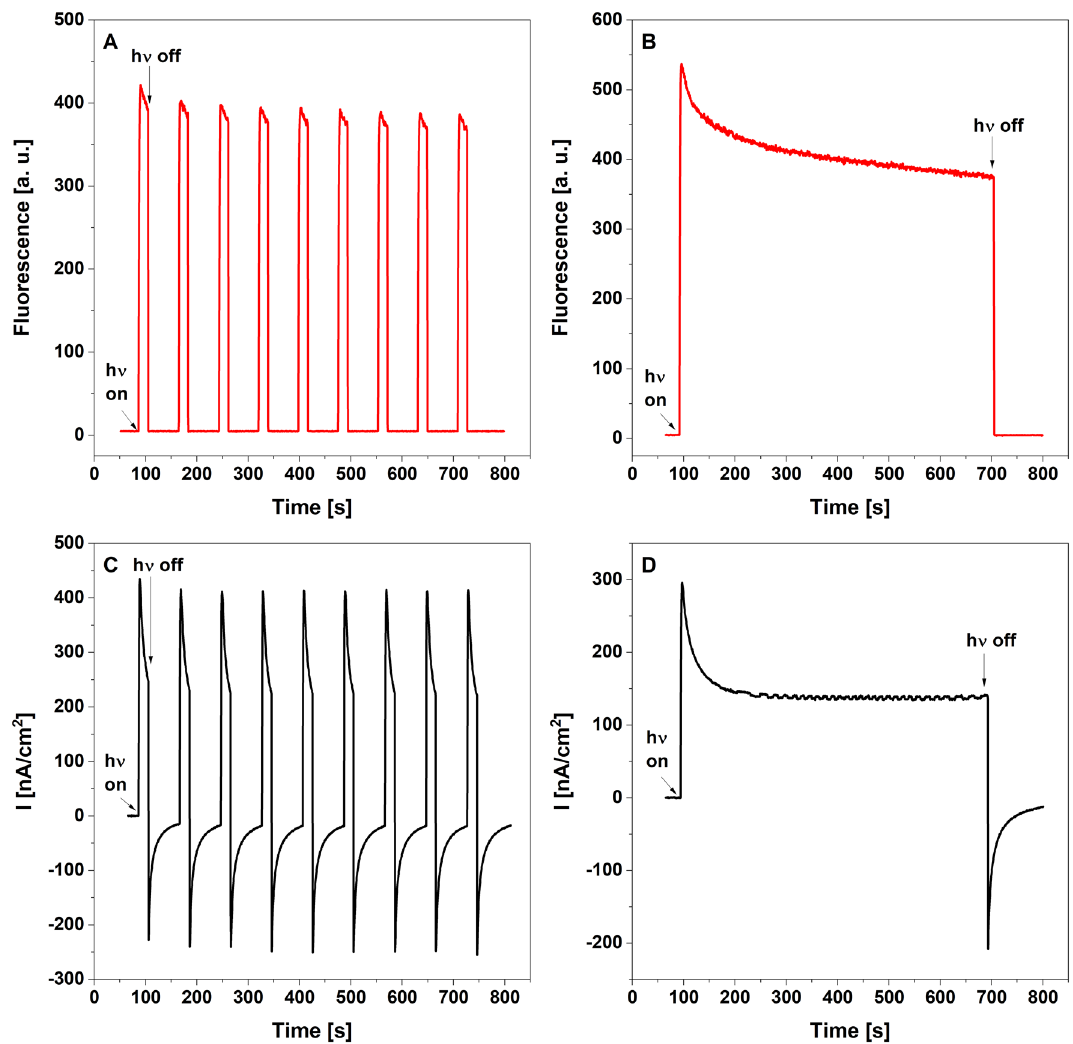
Figure 1. Simultaneous measurements of fluorescence emission and photocurrent generation in GE-LHCII 3 - PPBQ system. Measurements were carried out under dark/light cycles ( A , C ) as well as continuous illumination ( B , D ). The fluorescence traces were presented as red lines ( A , B ) whereas the respective photocurrent response as black lines ( C , D ). The sample was excited with the actinic blue light intensity of 4900 µE. The arrows show the points of switching on and off the actinic light. The presented data are representative of at least 10 separate